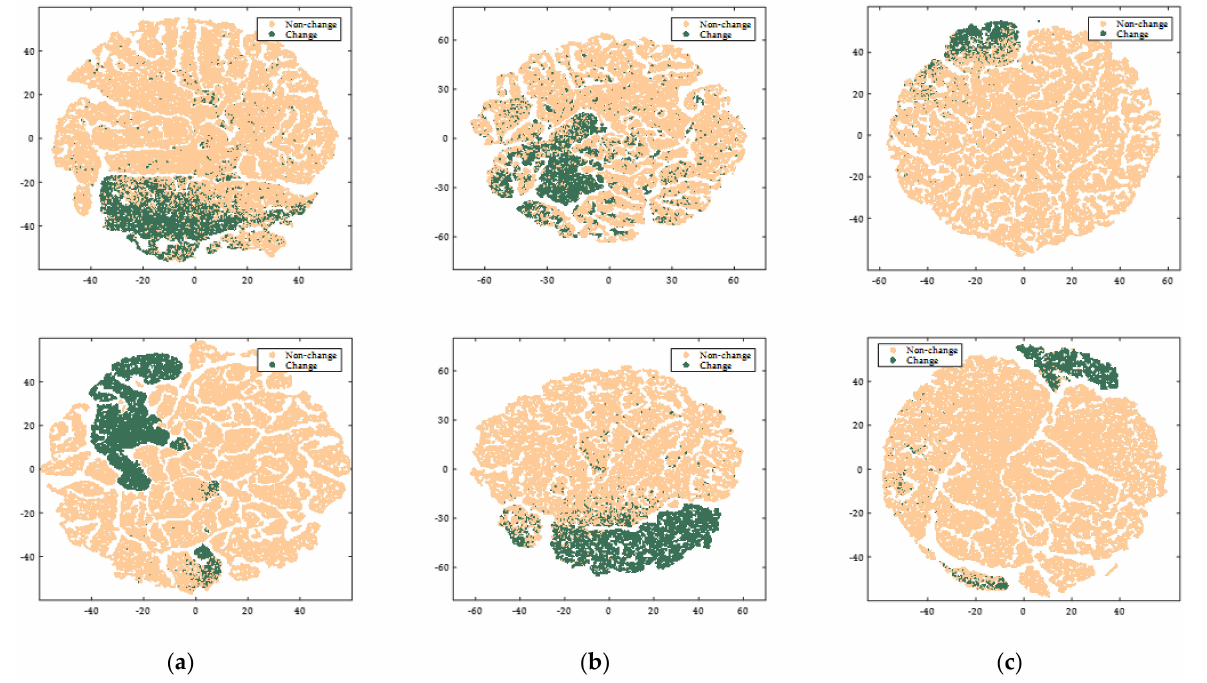
Figure 9. T–SNE visualization of the shallow ESP features (first row) and the learned high-level features by HVANet after training (second row) on ( a ) Ottawa dataset, ( b ) Farmland A dataset and ( c ) Farmland B